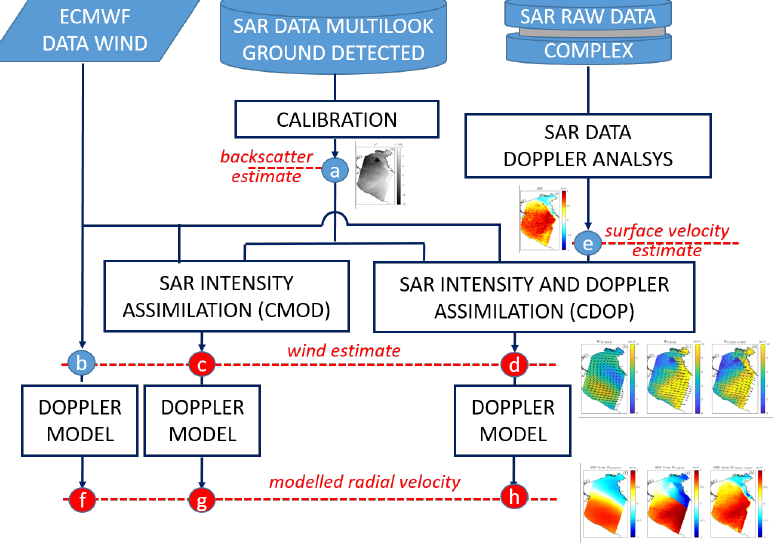
Figure 3. Schematic representation of the overall data